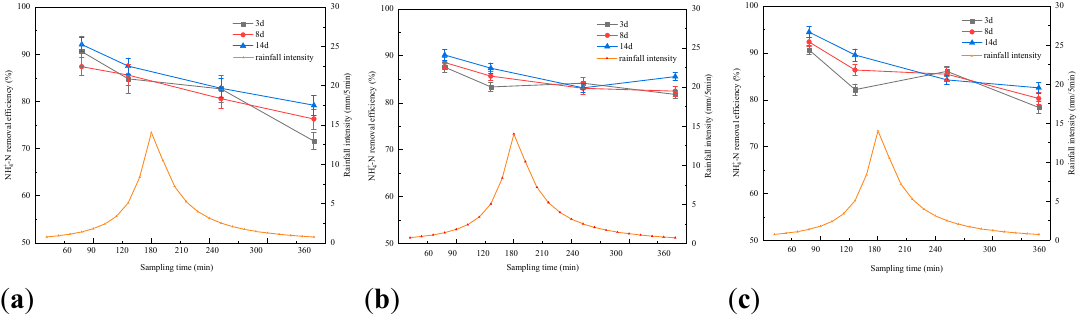
Figure 7. Efficiency of NH 4+ -N removal using bioretention systems with the ( a ) Control column, ( b ) DS column, and ( c ) SZ column during different antecedent dry periods.